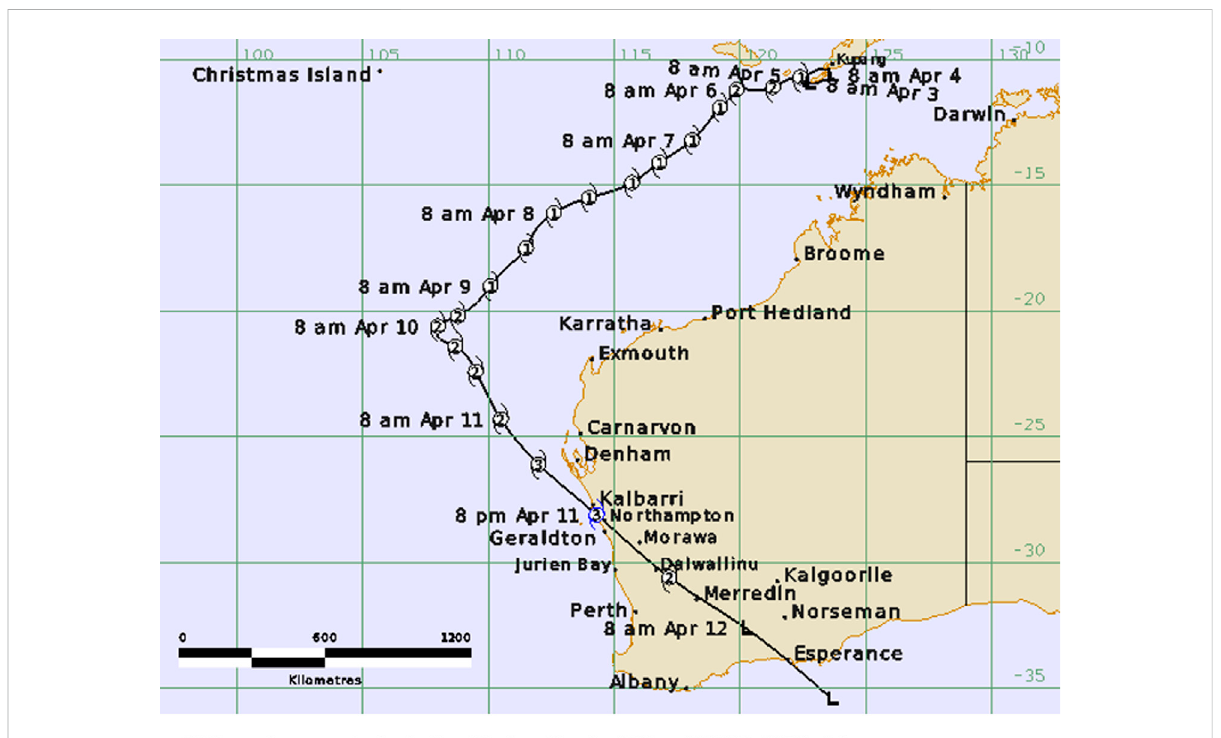
FIGURE 4 Track of TC seroja ( Bureau of Meteorology